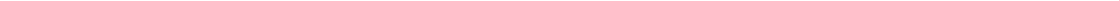
Fig. 1 FACS and in vitro analyses of PCs and BMSCs. a Experimental design of periosteal cells (PCs) and bone marrow stromal cells/skeletal stem cells (BMSCs) cultures from Prx1-Cre;YFP fl / + or Prx1-Cre;mTmG mouse hindlimbs. Bone marrow cells were fl ushed from hindlimbs and plated to obtain adherent bone marrow cells (aBM). After expansion, lineage depletion was performed to isolate BMSCs with no further passage. The fl ushed bones were placed in culture to isolate in one step the PCs migrating out of the explants. b Flow cytometry analyses of PCs and BMSCs isolated from Prx1-Cre;YFP fl / + mice. PCs and BMSCs negative for endothelial/hematopoietic markers (CD31, CD11b, CD34, and CD45) and double-positive for Sca1/CD29 are largely YFP + (derived from Prx1-mesenchymal lineage). c Quantitative RT-PCR analyses of FACS sorted GFP-positive and GFP-negative PCs and BMSCs isolated from Prx1-Cre;mTmG mice. Results show overexpression of the markers PDGFR α , Gremlin1 , Cxcl12 , and Nestin and to a lesser extent NG2 in GFP-positive compared to GFP-negative PCs, but not LeptinR . d CFE assays showing PCs forming colonies at cell density as low as 400 cells/cm 2 14 days after plating and BMSCs at 2000 cells/cm 2 14 days after plating. Colonies were stained with Giemsa blue and counted under microscope. e Cell-growth assay shows that PCs grow faster than adherent bone marrow cells (aBM) and BMSCs. The cells were plated at the same density (10 5 cells/dish) and counted every day during the fi rst two days then every two days for 12 days (* represents the comparison between PCs and aBM, $ represents the comparison between PCs and BMSCs). f In vitro differentiation of PCs and BMSCs into osteogenic (3 weeks), adipogenic (3 weeks), and chondrogenic (2 weeks) lineages as shown by alizarin red S, Oil red O, and alcian blue staining, respectively. Due to the poor chondrogenic capacity of BMSCs, aBM were assessed for chondrogenesis. Statistical differences between the groups ( n = 3 or 4 per group) were determined using Mann – Whitney test (*,$ p ≤ 0.05, **,$$ p < 0.001, ***,$$$ p < 0.0005). All data represent mean ±